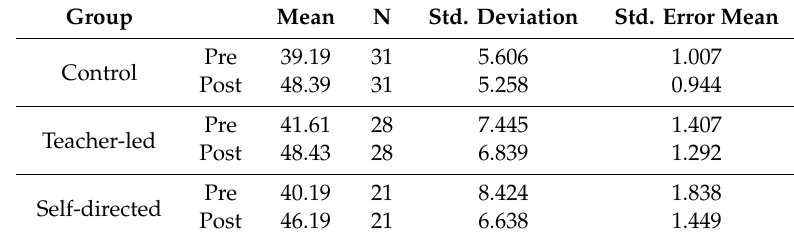
Table 5. Descriptive statistics for listening performance.